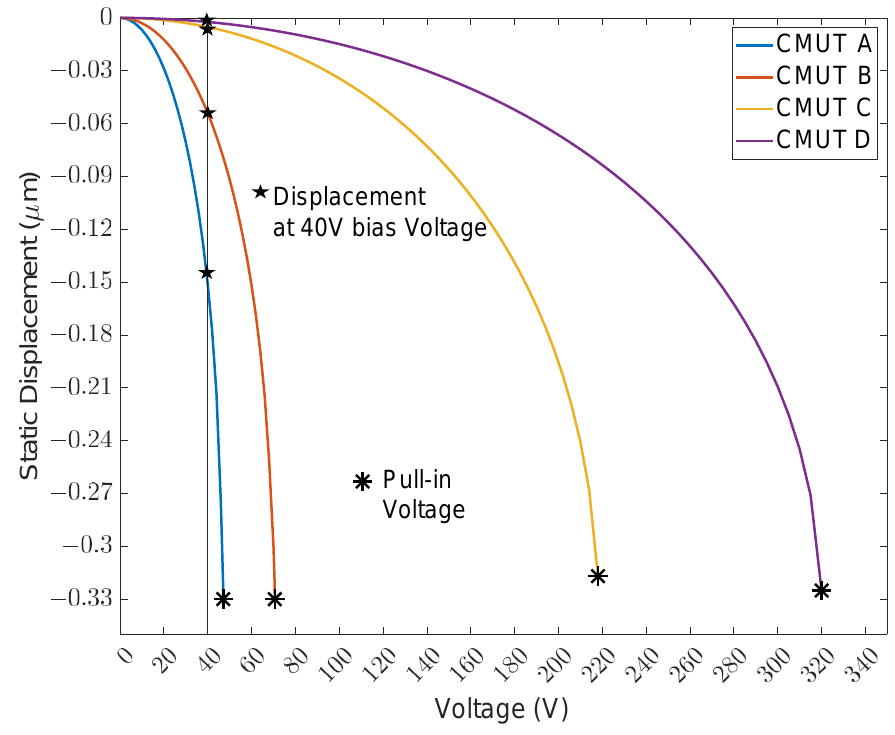
Figure 8. Static displacement vs. DC bias